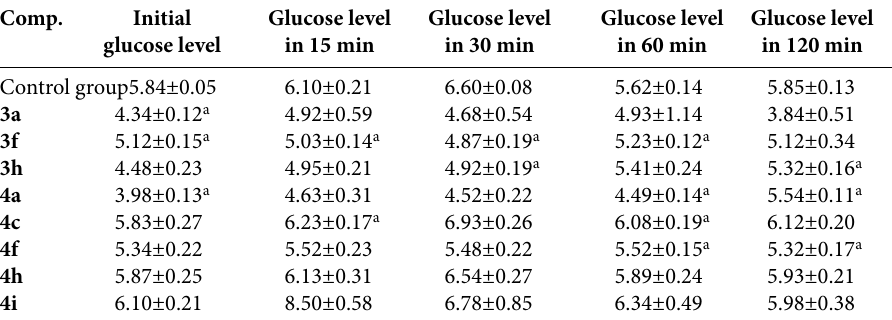
Table 3 Influence of synthesized compounds on glucose level in blood of experimental animals in the short term of the experiment Comp.